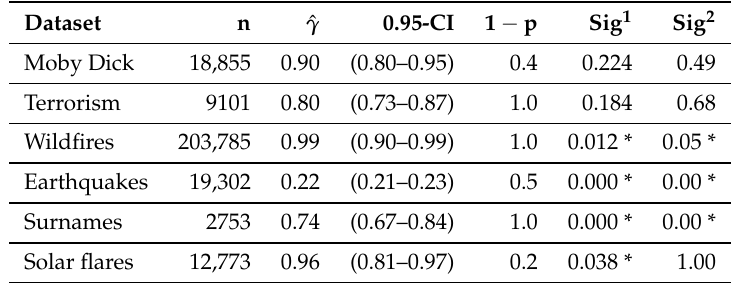
Table 9. Sample size, estimated γ and 95% confidence intervals for the six data-sets. Fraction of upper order statistics used ( 1 − p ) and p -values of the testing procedures defined in Taufer et al. [33] (Sig 1 ) and Clauset et al. [1] (Sig 2 ). Asterisk indicates significant